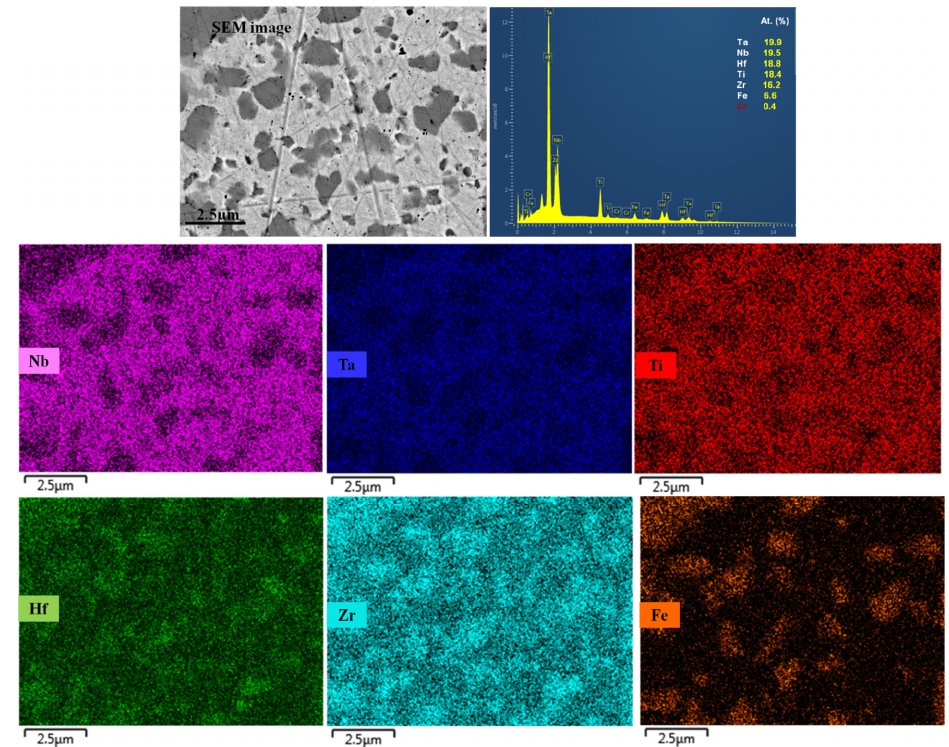
Figure 12. Representative compositional EDX mapping results for the HfTaTiNbZr sample prepared by the combined use of HEBM ( t = 90 min) and SPS consolidation at 1300 °C ( τ = 10 min).